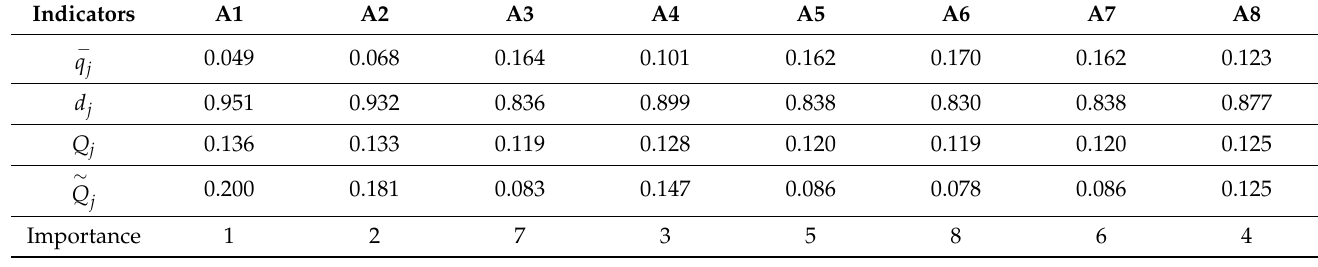
Table 3. Distribution of factors according to importance.